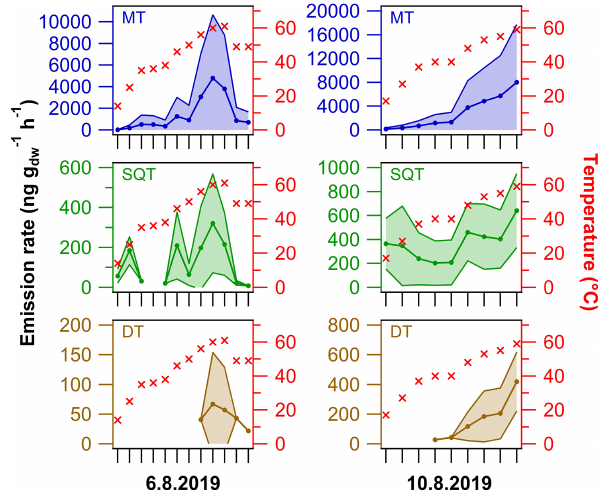
Figure 9. Semi-quantitative average ( ± standard deviation) emis- sion rates of MTs, SQTs and DTs from the living spruce branch enclosure experiments on two different sampling dates. The cu- vette inside temperature is shown on the right y axis (for details see Fig. S5). For details on the terpenes included, see Table